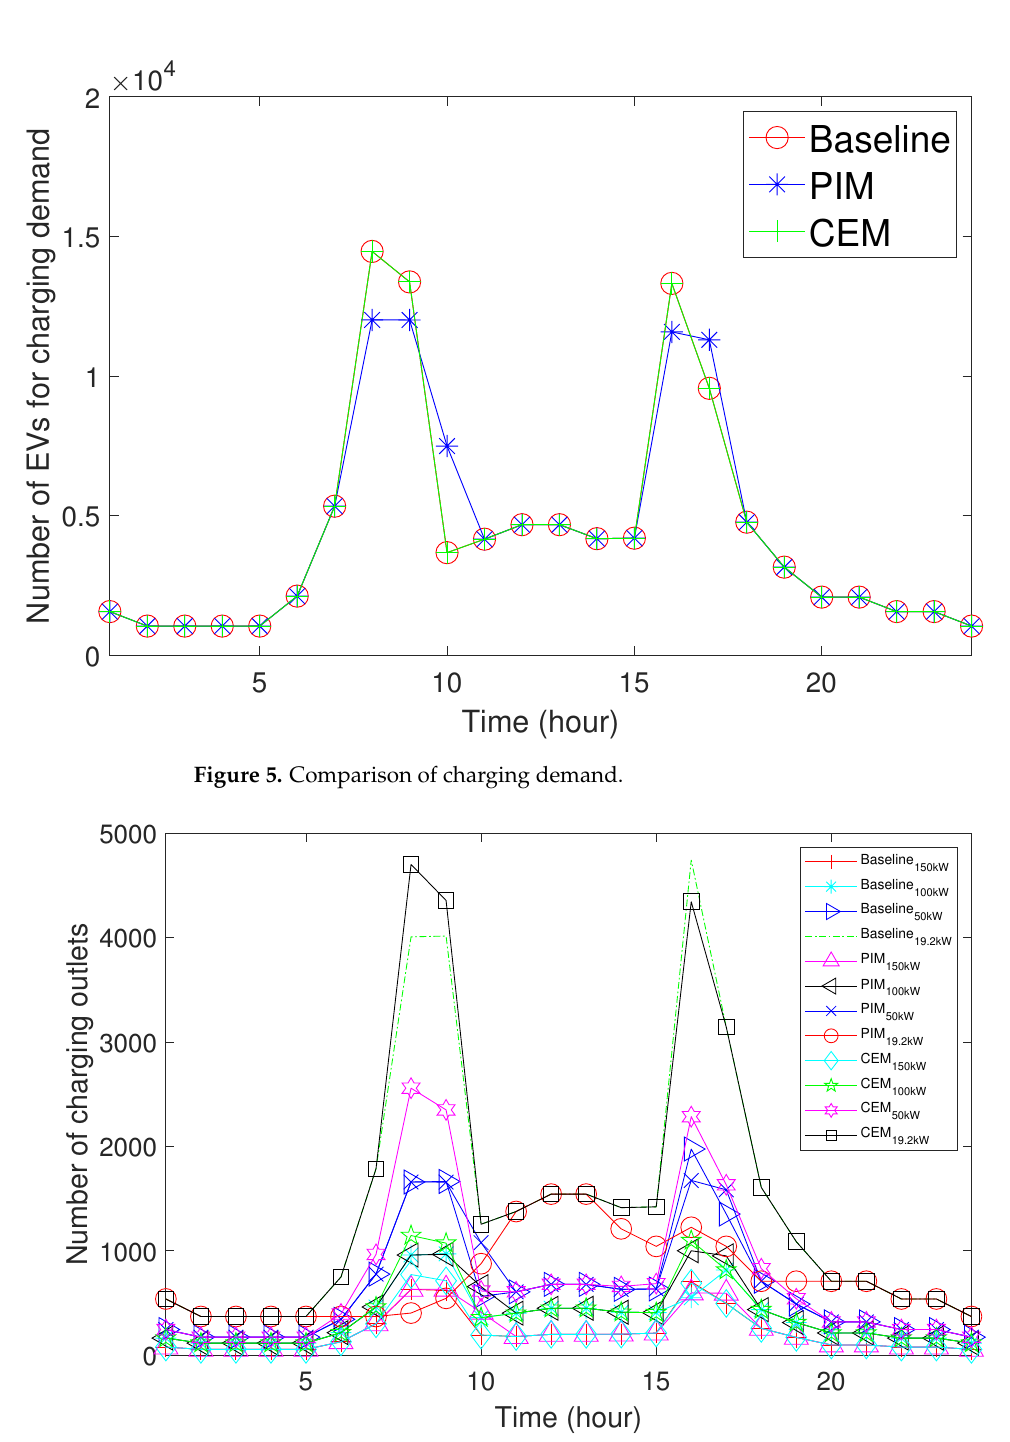
Figure 6. Allocation of charging